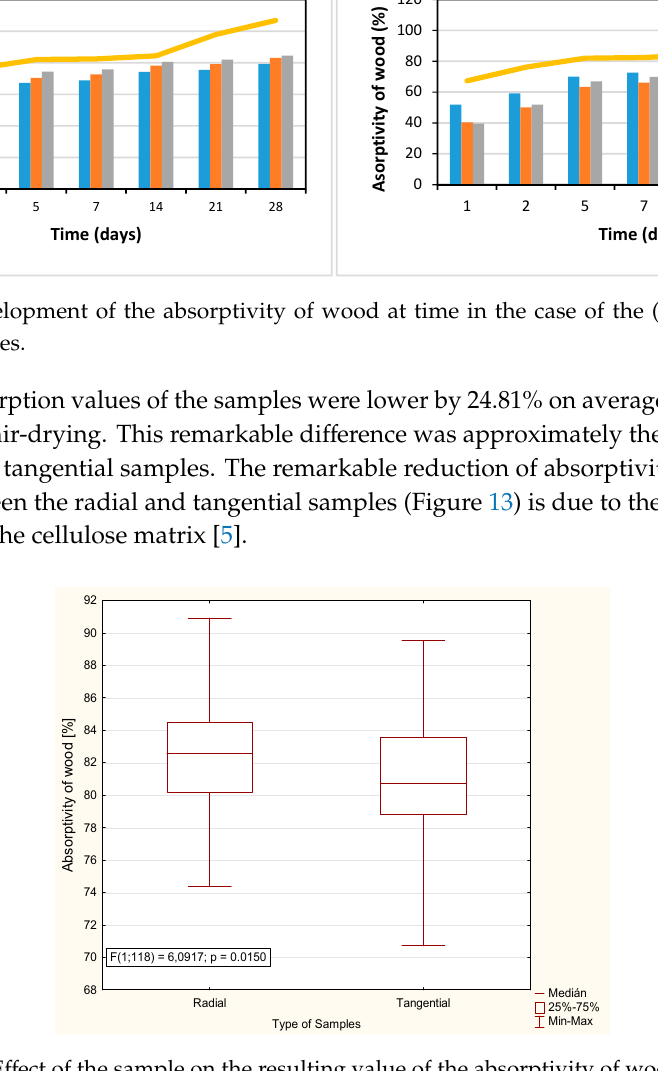
Figure 13. Effect of the sample on the resulting value of the absorptivity of wood ( p < 0.05).